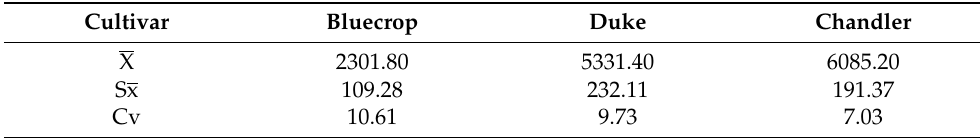
Table 2. Average number of fruits per bush.